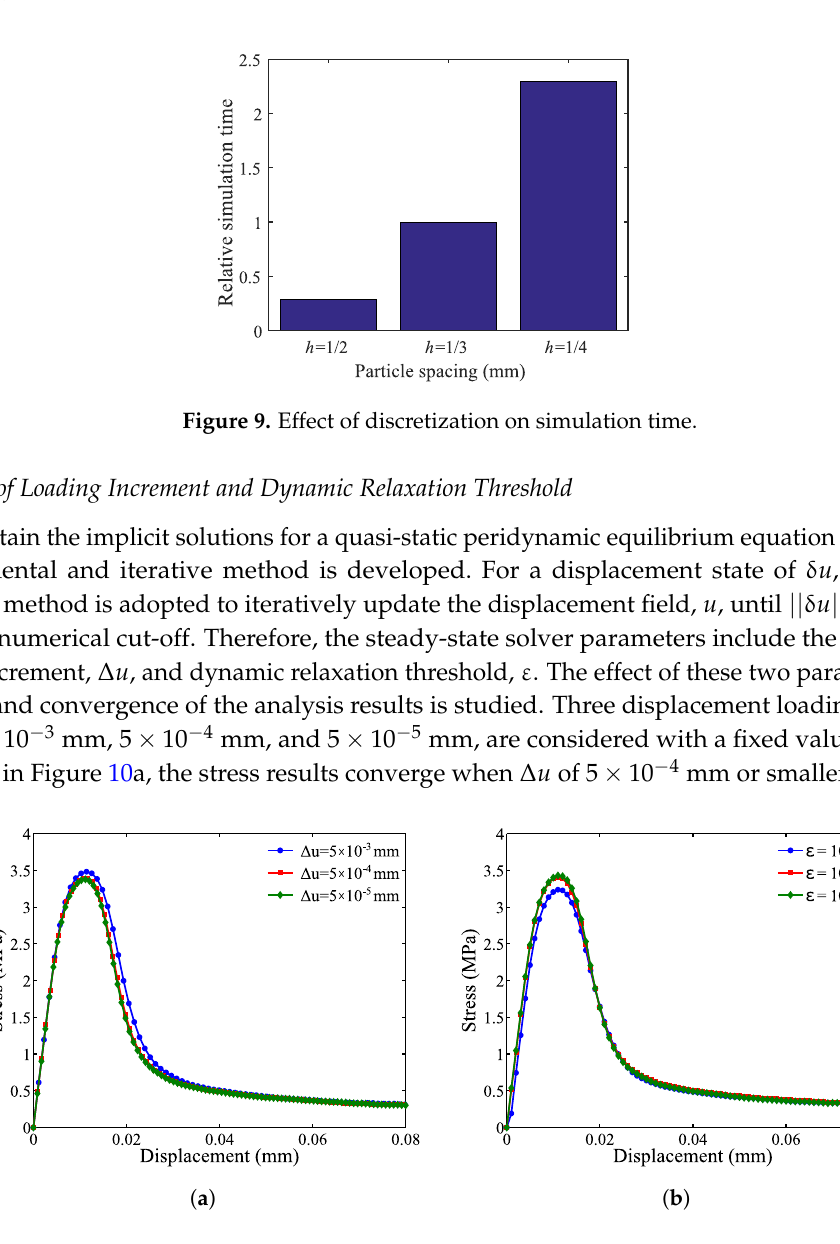
Figure 10. Effect of ( a ) the displacement loading increment and ( b ) the dynamic relaxation threshold on the mean stress